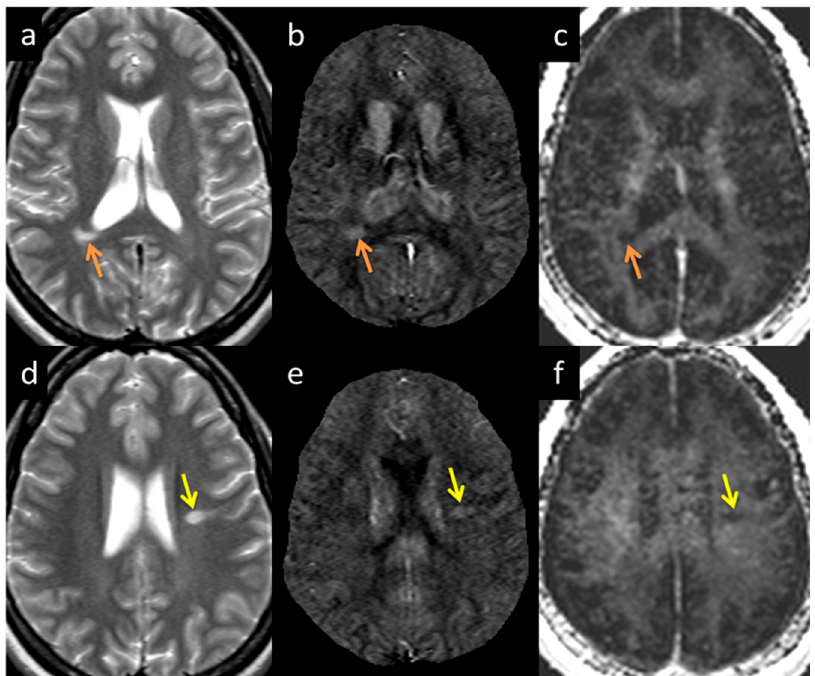
Figure 7. Lesion appearance example in two different subjects: Subject 1 ( a – c denoted by the orange arrow) and Subject 2 ( d – f denoted by the yellow arrow) in T2WI ( a , d ), QSM ( b , e ), and MWF ( c , f ). The lesions appearing in MWF ( c , f ) also appear bright in QSM ( b , e ) with high susceptibility directly correlating to demyelination.